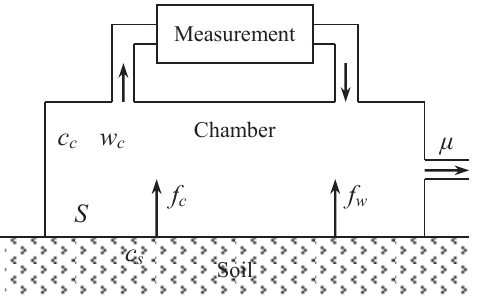
Figure 2. Measuring model of dynamic chamber method. S : area of soil surface covered by the chamber; c c : mole fraction of CO 2 in the chamber; w c : mole fraction of water in the chamber, f c : emission rate of carbon dioxide from the soil, f w : emission rate of water vapor from the soil, c s : mole fraction of CO 2 in soil, µ : rate of gas emission for the